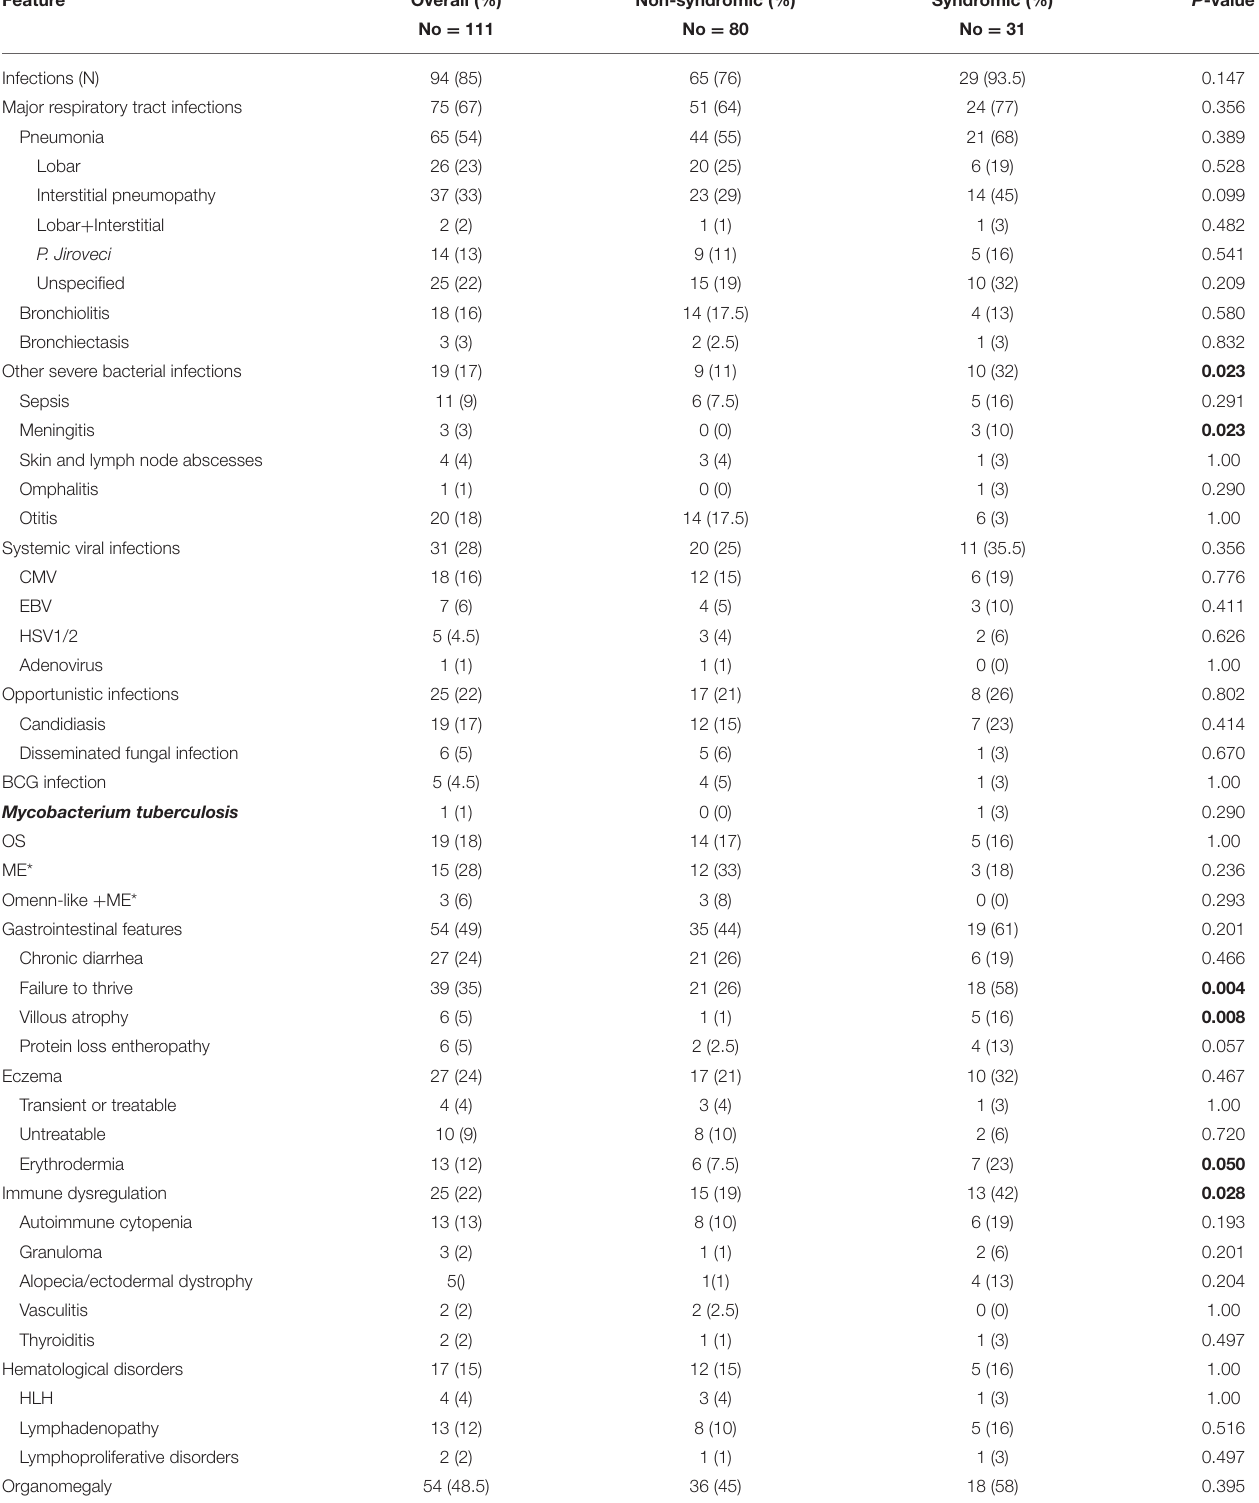
TABLE 2 | Clinical features of patients at